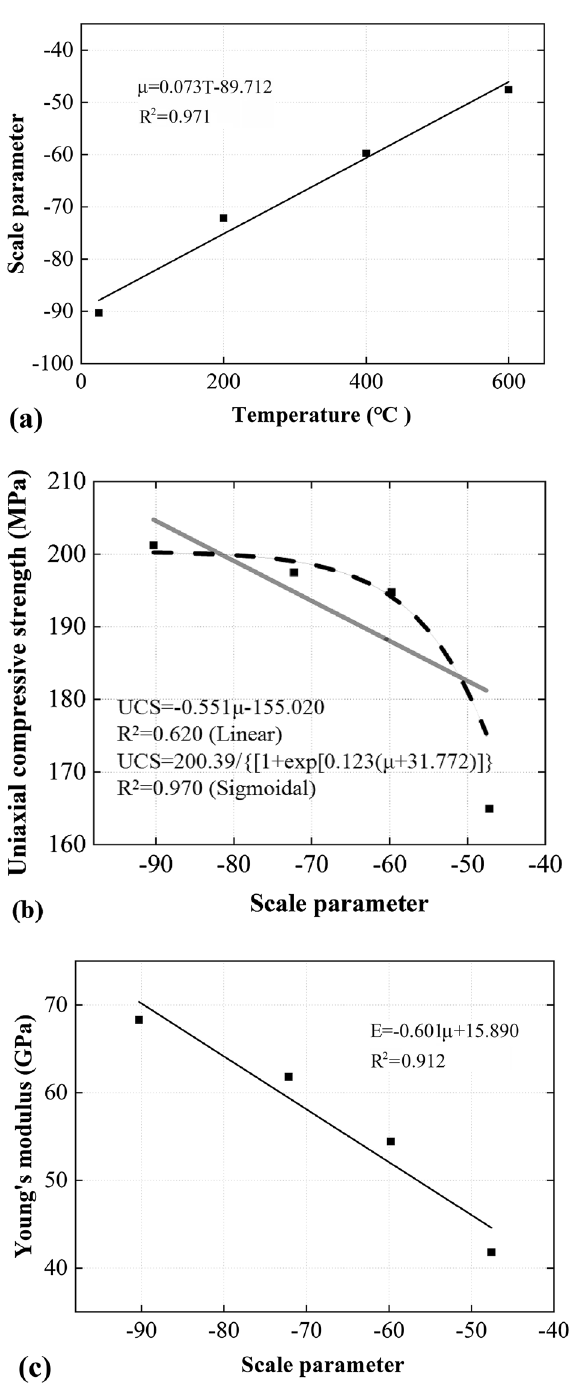
Figure 8. Correlations between ( a ) scale parameter and treating temperature, ( b ) UCS and the scale parameter and ( c ) E and the scale